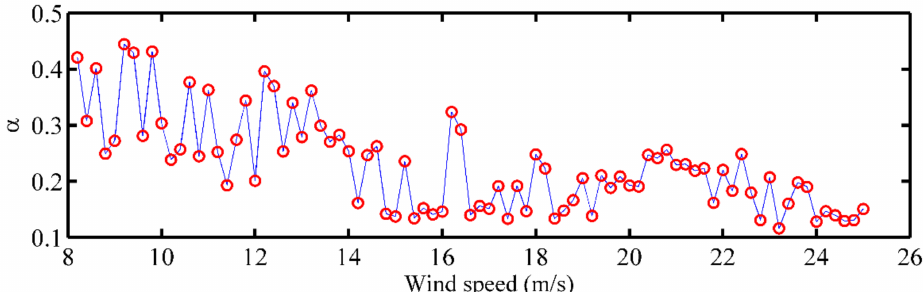
Figure 10. Wind profile parameters with different wind